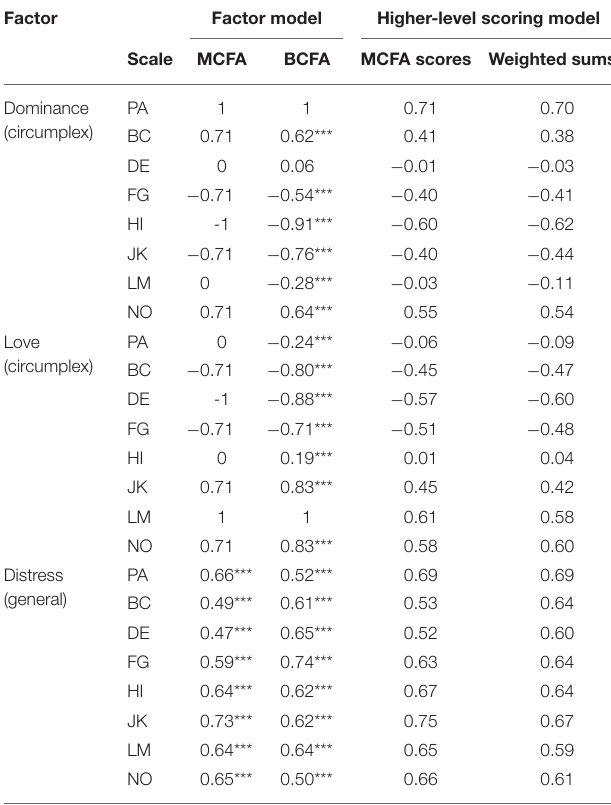
TABLE 2 | Loadings from the three-factor model (MCFA and BCFA) and from higher-level scoring models of the inventory of interpersonal problems.